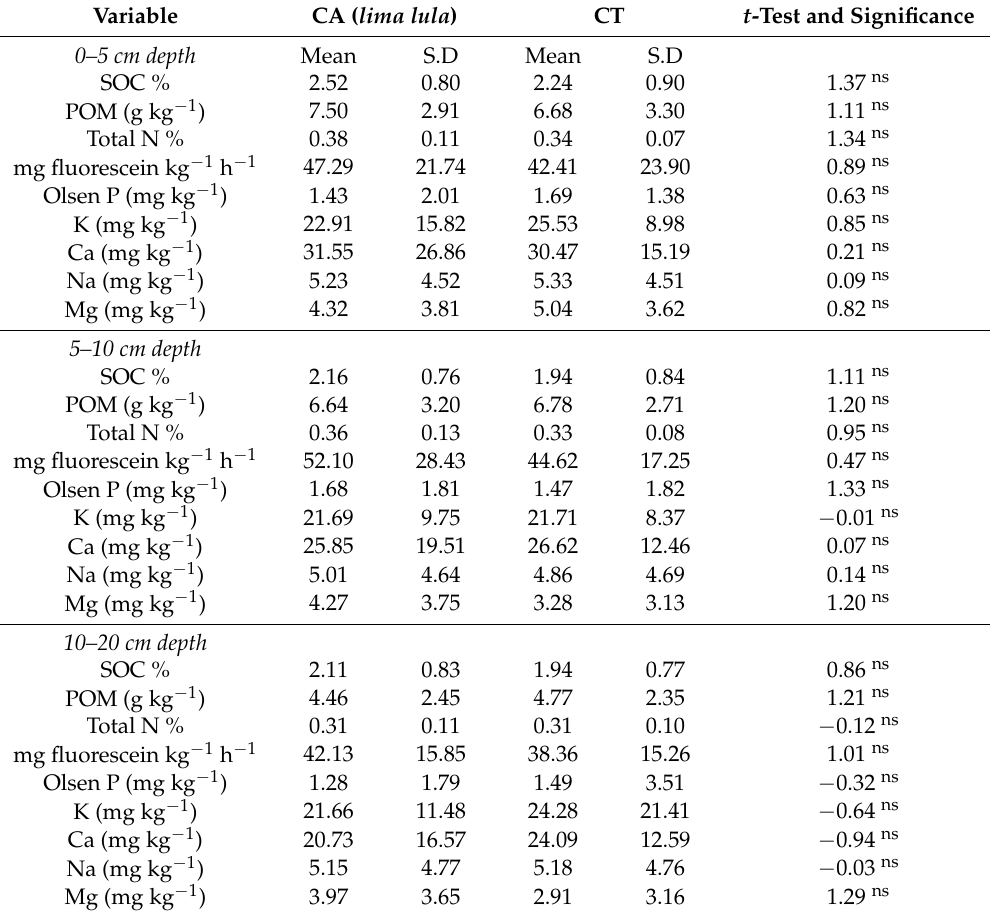
Table 9. A comparison of selected soil quality indicators between CA and conventional tillage (CT) fields on smallholder farms in the Eastern Cape Province ( n =